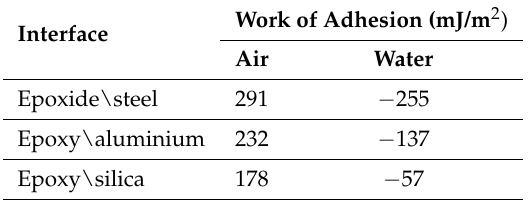
Table 4. Values of work of adhesion for various interfaces in dry air and water, data from